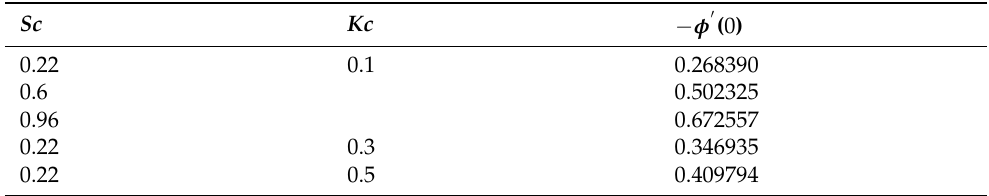
Table 4. Calculations of − φ (cid:48) ( 0 ) for diverse Sc and Kc quantities with Pr = 6.2, M = 0.1, K = 0.2, Ec = 0.02, and β =